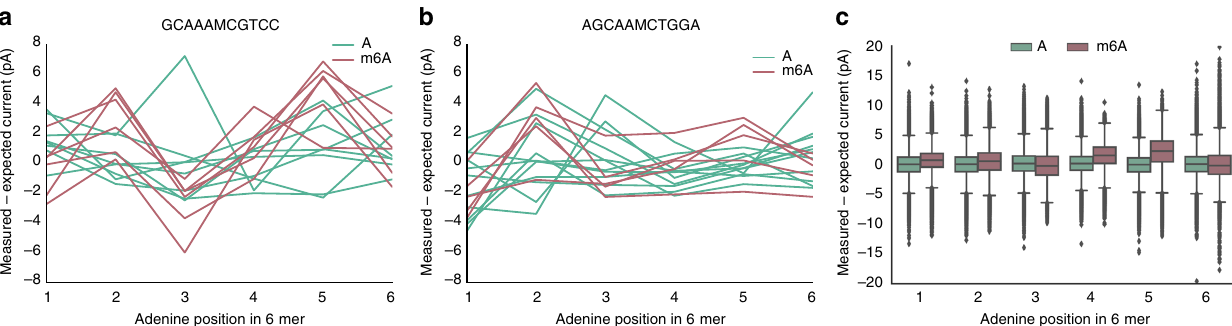
Fig. 1 m 6 A methylation affects nanopore signal. Picoampere currents deviate from model values as the DNA surrounding a methylated adenine is pulled through a nanopore. a , b The deviations vary according to the position of the adenine within the pore and its surrounding sequence context. c Across all sequence contexts, the greatest deviations for R9 data occurred with the adenine in the fourth or fi fth position among six nucleotides considered by the model in and around a pore. Boxplot center lines show medians and whiskers 1.5× interquartile range. Outliers are truncated at + / − 20 pA to